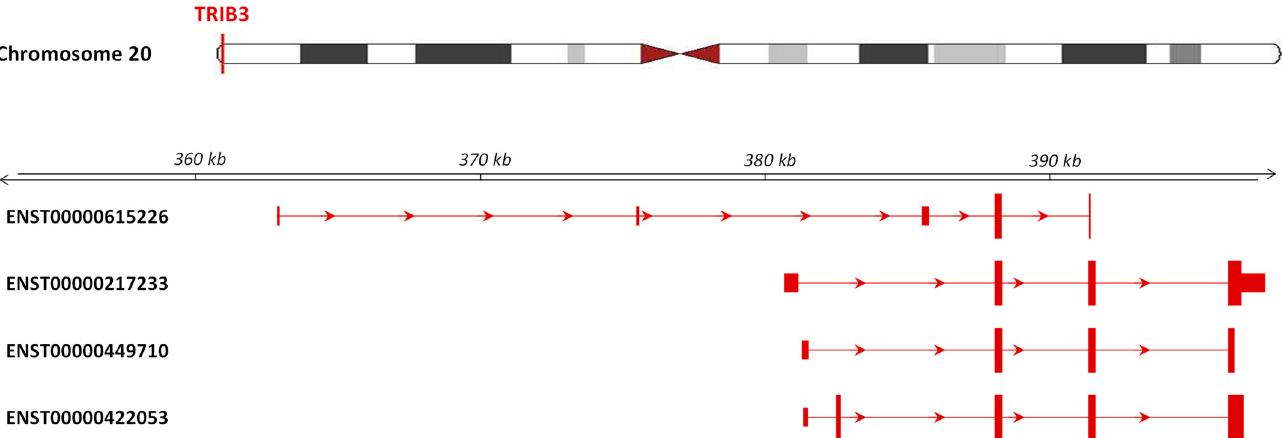
Figure 1. Transcript variant analysis of the TRIB3 gene (ENSG00000101255.11). (Adapted from the Ensembl platform; https://www.ensembl.org accessed on January 2021).